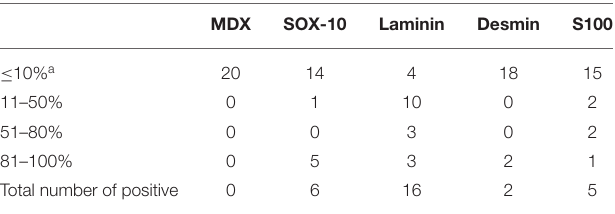
TABLE 2 | Number of cases with immunohistochemical expression of tested antibodies in oral spindle cell tumors (OSCT). MDX SOX-10 Laminin Desmin S100